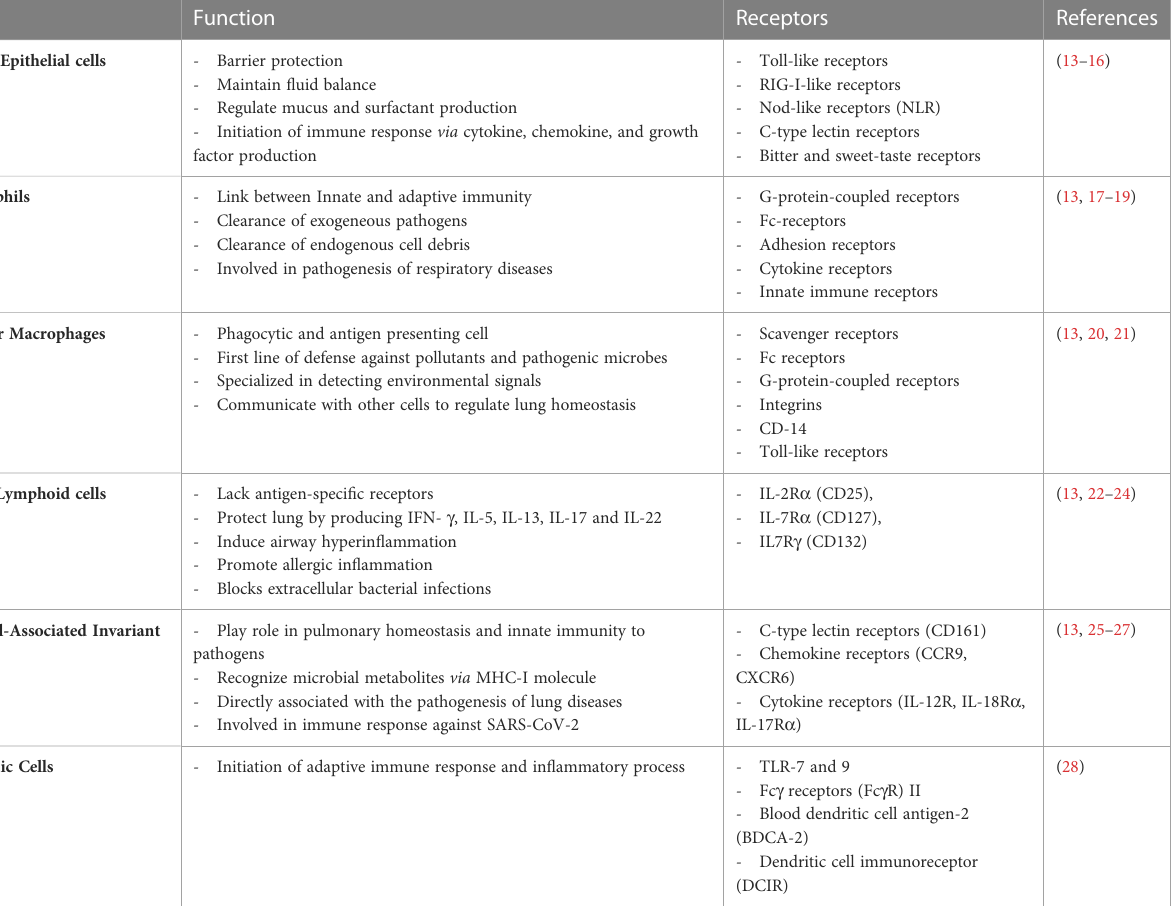
TABLE 1 Cells involved in primary Immune response of the lung. Cells Function